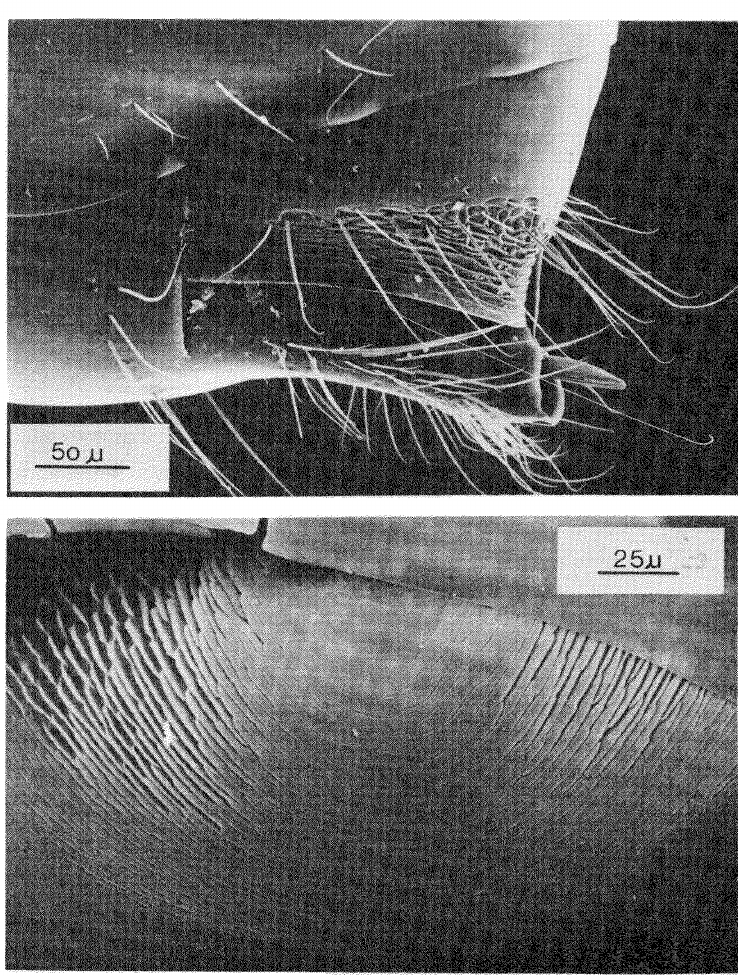
Fig. 5. Above: SEM pictures of the gaster tip of a media of Orectognathus versicolor. The slightly extruded stinger is visible. It is surrounded by long sensory setae (confirmed by histology; probably mechanoreceptors) on the edge of the pygidium and 7th sternum. Below: Groved cuticular structures on the pygidium associated with the pygidial gland. This structure is usually covered by the preceding 6th